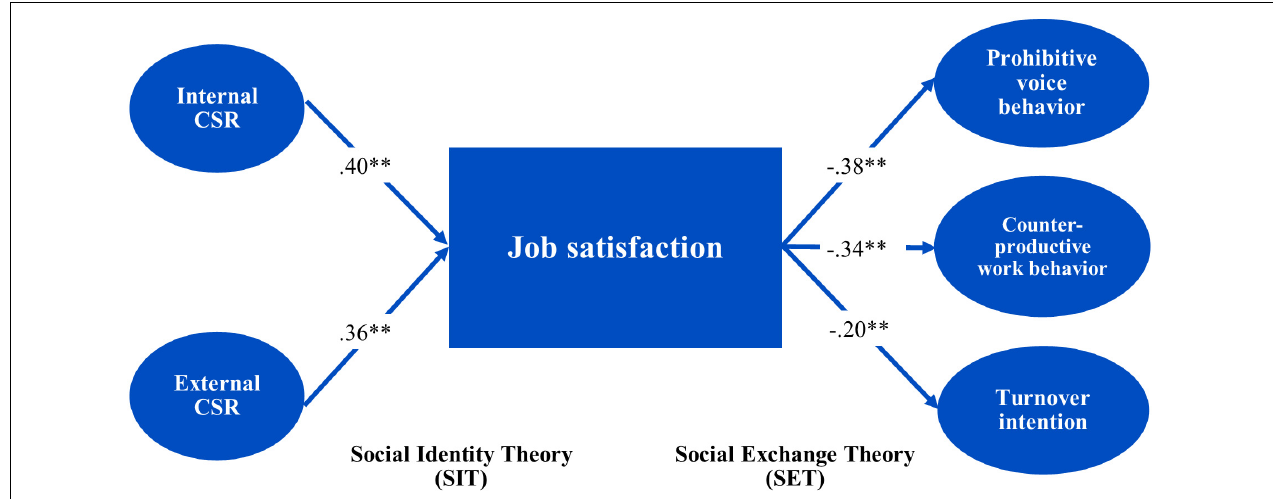
FIGURE 2 | The estimated model of the relationship between perceived CSR and employee work behaviors through mediation mechanism. Values given on the paths are standardized regression coefficients. Values denoted with ( ∗∗ ) are significant at